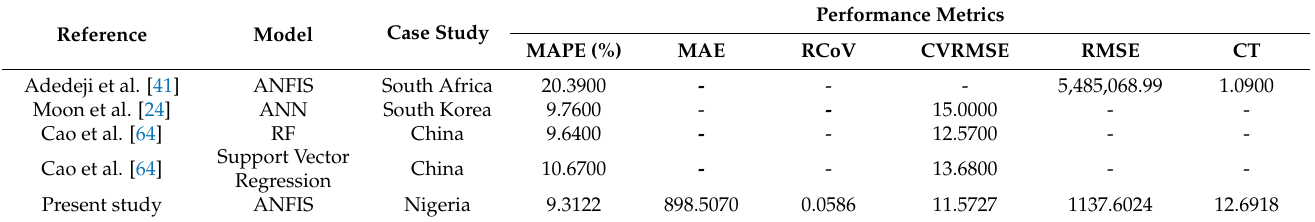
Table 8. Comparison of the sub-optimal model with previous works, involving energy usage